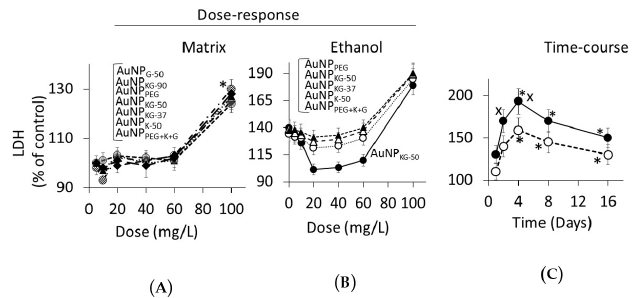
Figure 11. ( A ) Plots of dose (AuNP mg/L) versus lactate dehydrogenase (LDH) activity in Ap/En cells (% of control) at day 16. A 5 to 60 mg/L dose of all AuNPs exhibited comparable response. Only 100 mg/L dose caused significant in enzyme activity. Values are mean ± SD; ( B ) Plots of dose (AuNP